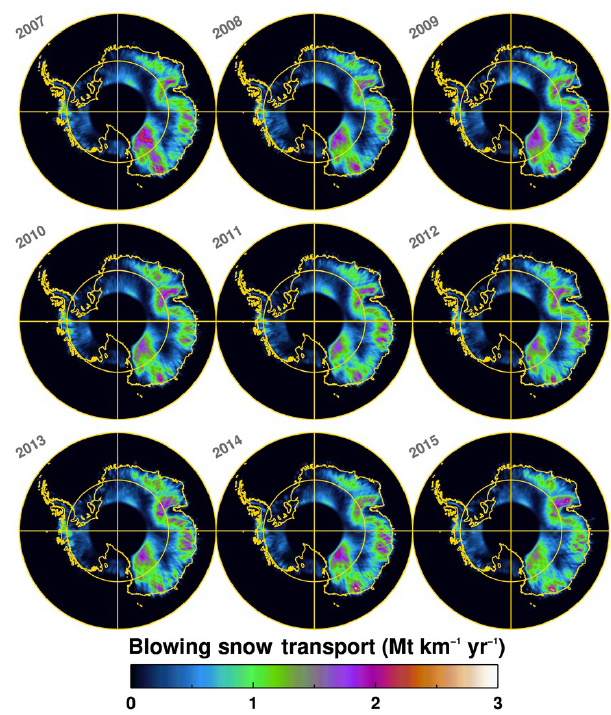
Figure 8. The magnitude of blowing snow transport over Antarctica integrated over the year for years